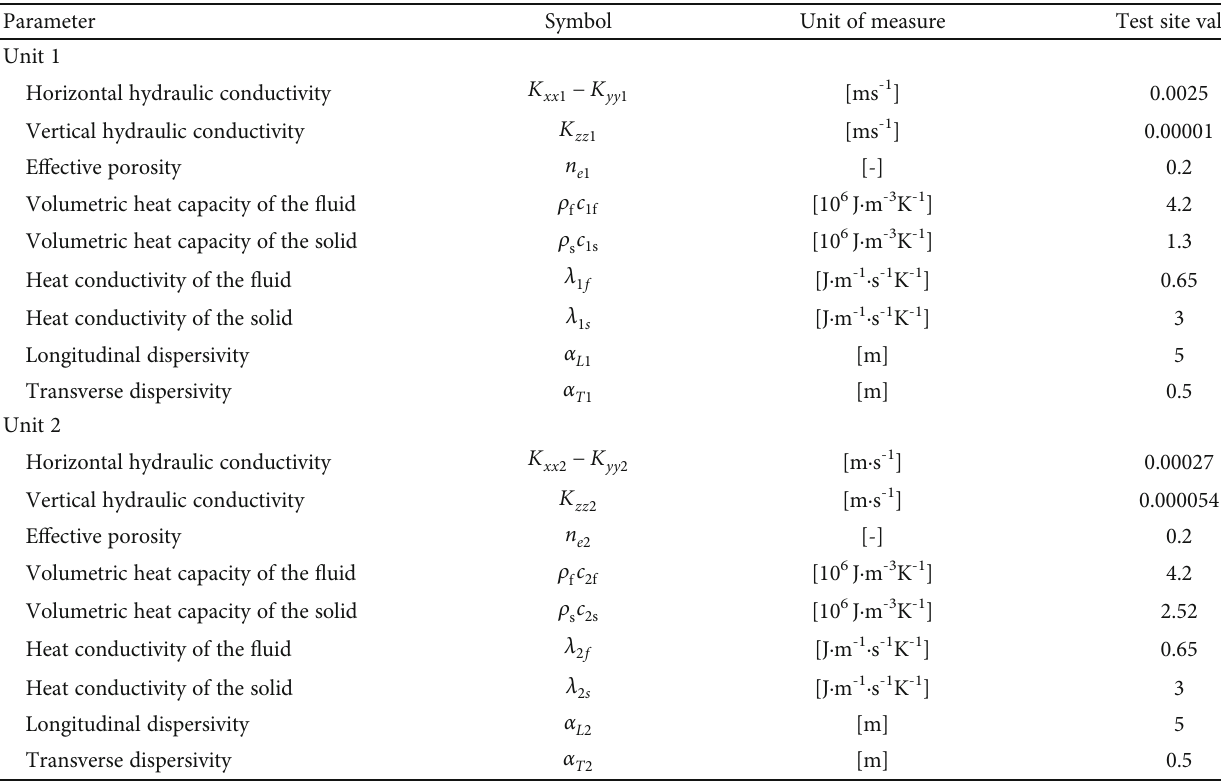
Table 2: Thermal and hydrodynamic parameters used as input data in FEFLOW modelling (unit 1 and unit 2)